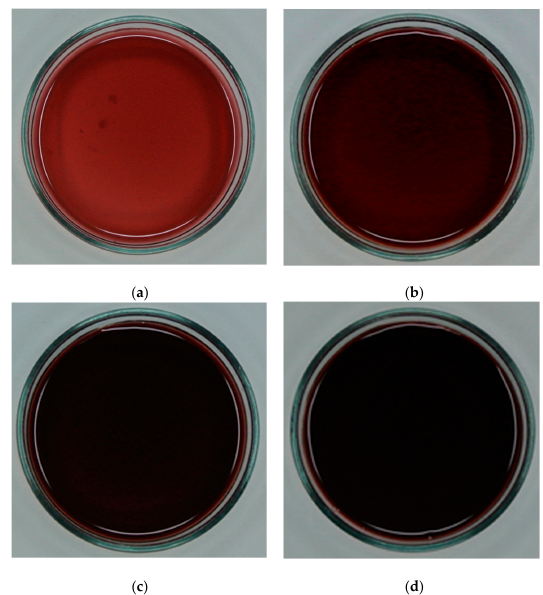
Figure 1. Effect on visual color of different BFC applied to fresh blueberry juice: ( a ) Fresh juice; ( b ) GBFC; ( c ) CBFC; ( d ) CFBFC. 3.2. Determination of Total Phenolic Content (TPC), Total Anthocyanin Content (TAC), and Total Flavonoid Content (TFC) The polyphenolic compounds values of the samples (fresh blueberry juice, GBFC, CBFC and CFBFC) are shown in Figure 2. Firstly, fresh blueberry juice had TPC, TAC, and TFC values close to 135 mg GAE/100 g d.m., 33 mg C3G/100 g d.m., and 41 mg CEQ/100 g d.m., respectively. These results were lower than the reported by Casas-Forero et al. [43]